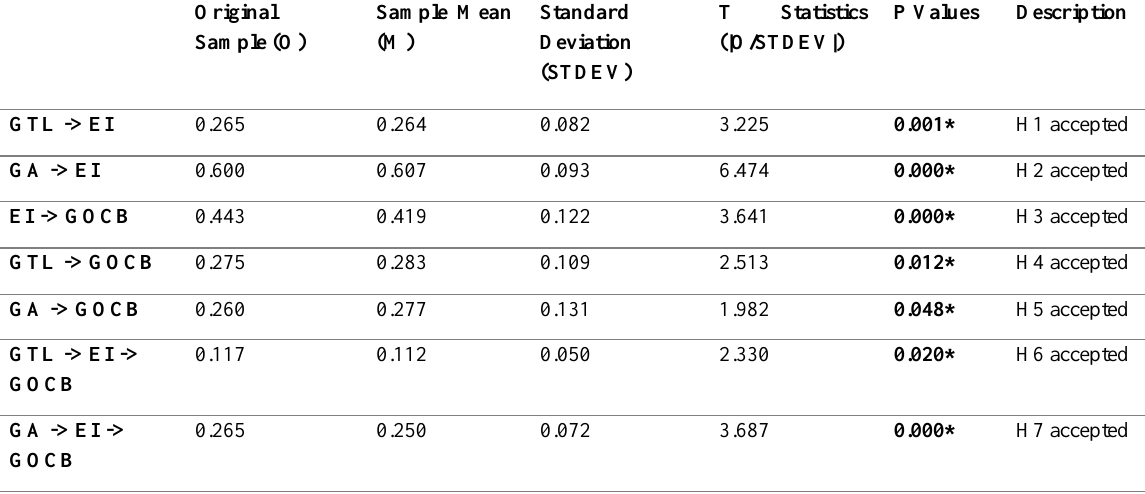
Table 6: Results of Testing Relationship Between Construct (Hypothesis